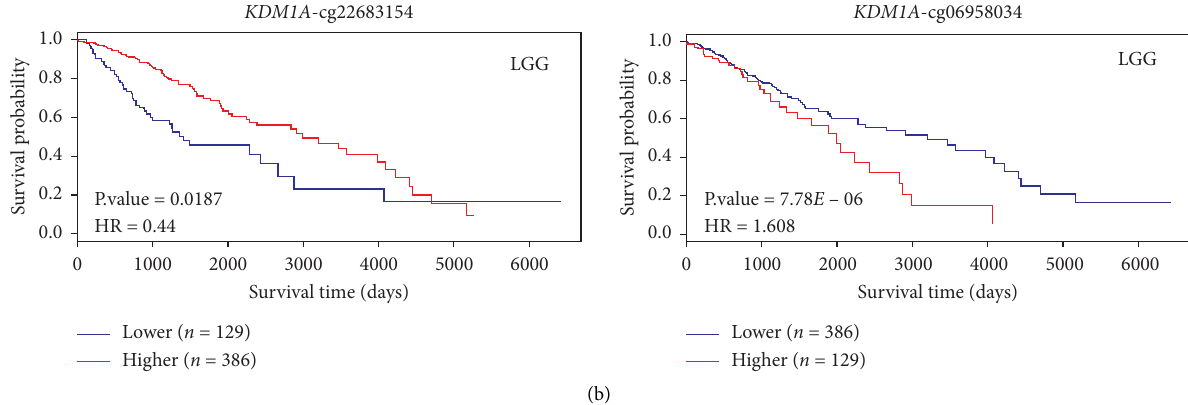
Figure 3: Correlation between DNA methylation of KDM1A and survival prognosis in TCGA tumors using MethSurv. The p value ( < 0.05) and the hazard ratio (HR) are